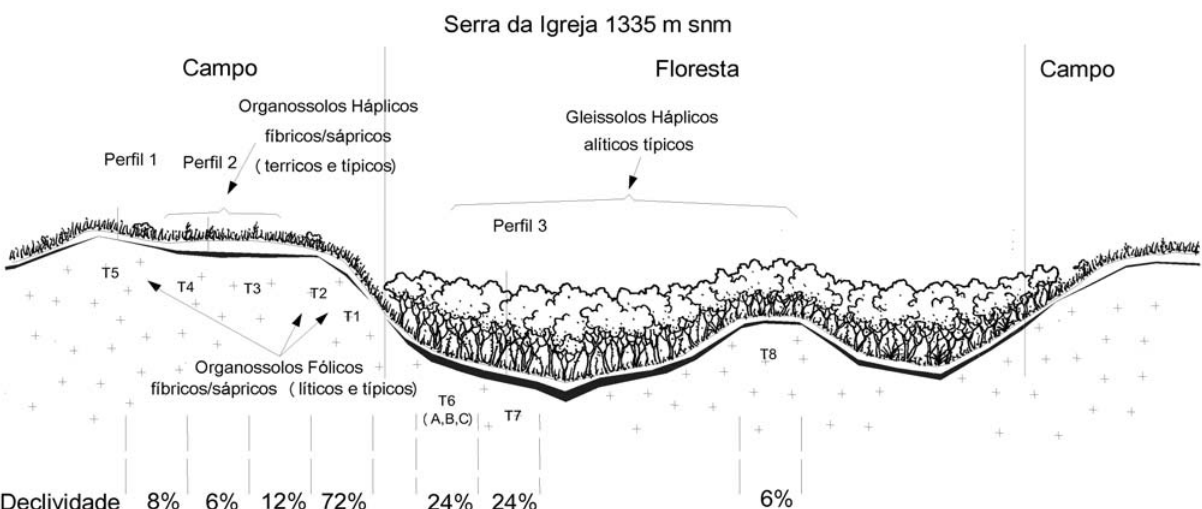
Paraná.Figura 2. Transecto com os pontos amostrados nos compartimentos por meio de tradagens e perfis. T: pontos